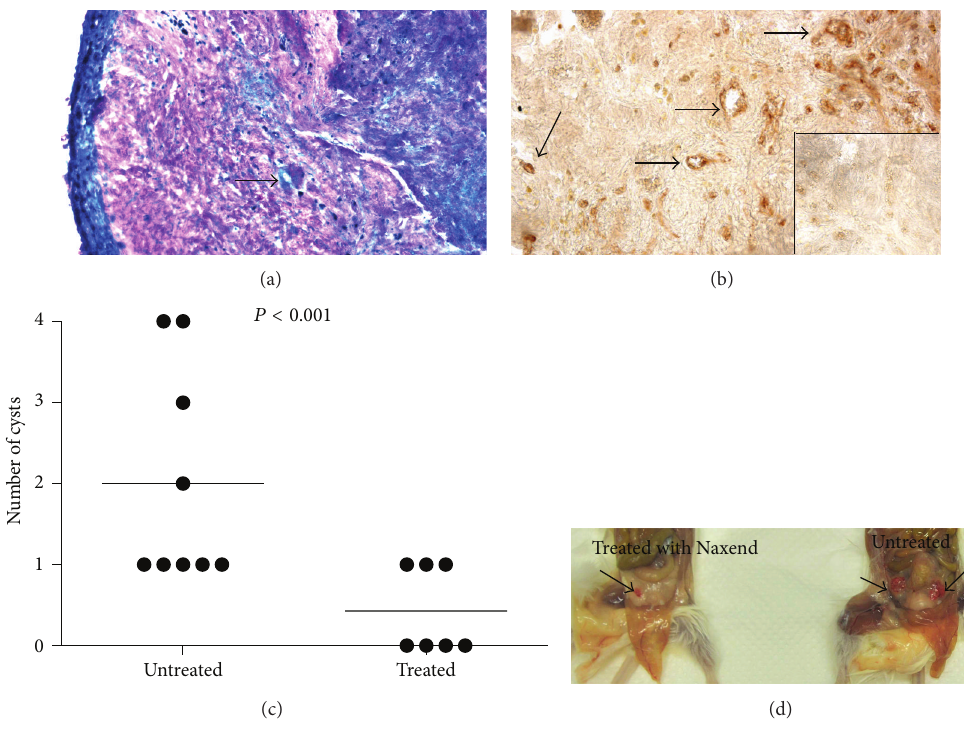
Figure 1: NAC/LA/Br reduces the number and the dimension of cysts in a new in vivo model of EM. (a) Histochemical analysis of an endometriotic lesion in mice with Diff-Quick staining. Original Magnification 100x. (b) Immunohistochemical analysis of a cyst excised from the peritoneum of mice. Sections were stained with rabbit anti-vWF followed by a secondary antibody to rabbit IgG HRP conjugated and revealed with DAB. The inset showed the staining obtained with only secondary antibody. Original Magnification 100x. (c) Number of cysts counted in untreated mice ( 𝑛 = 9 ) or treated with NAC 250 mg/kg/die, AL 125mg/kg/die, and Br 12,5 mg/kg/die ( 𝑛 = 7 ). Mann-Whitney test 𝑃 < 0.001 . (d) Representative image of the different morphological appearance of cysts in treated or untreated SCID mice.